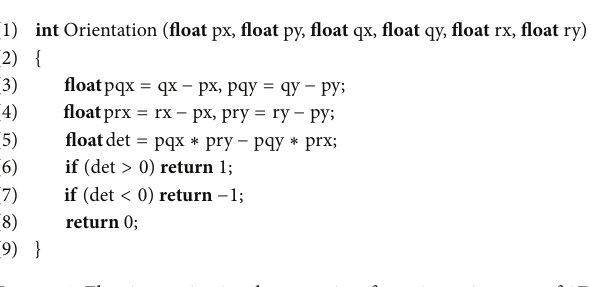
Figure 1: Floating-point implementation for orientation test of 2D